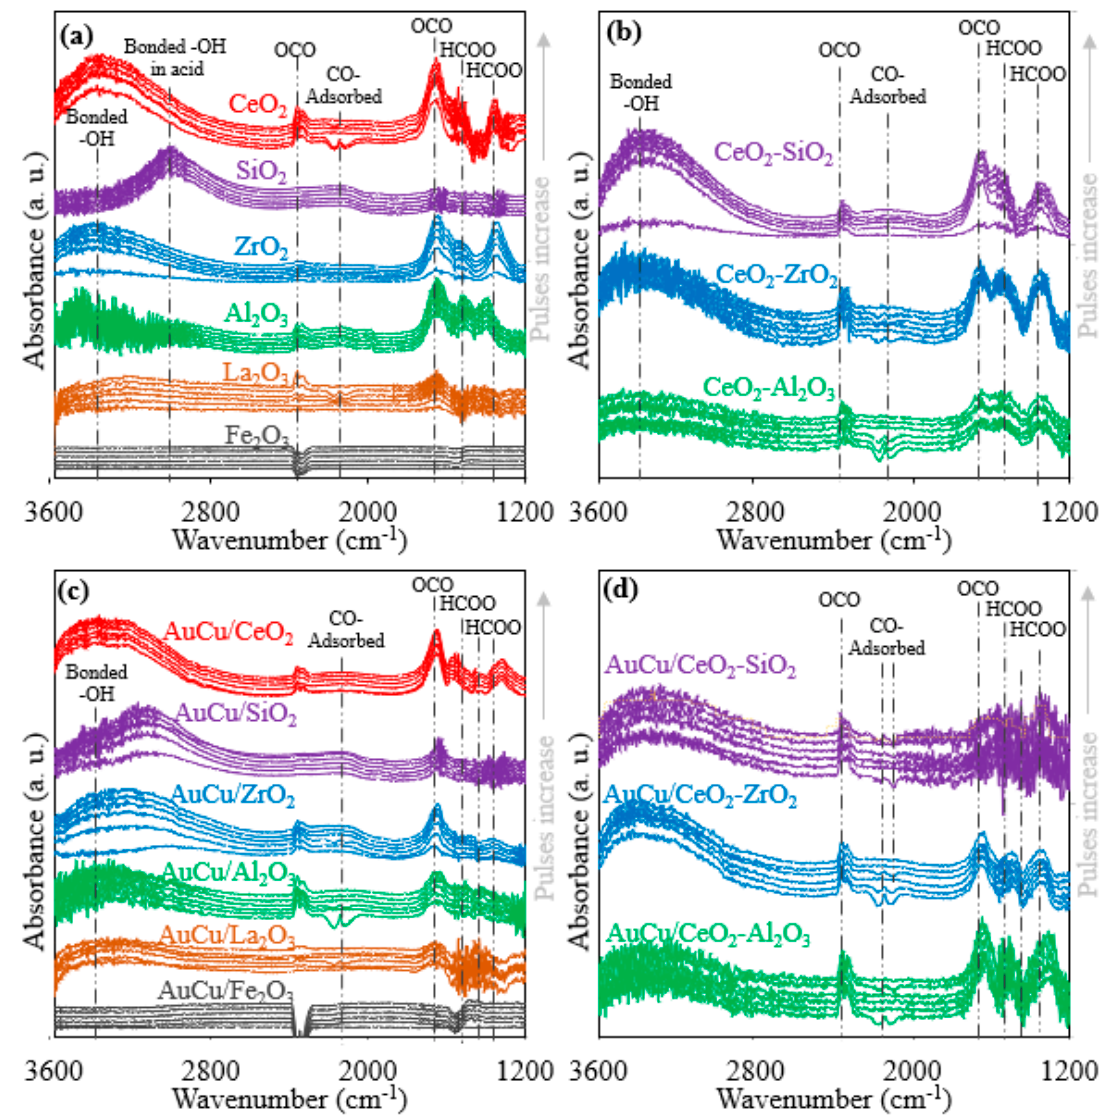
Figure 8. In situ diffuse reflectance infrared Fourier transform spectroscopy (DRIFTS) of CO adsorption of ( a , b ) bare supports and ( c , d ) supported Au–Cu catalysts.